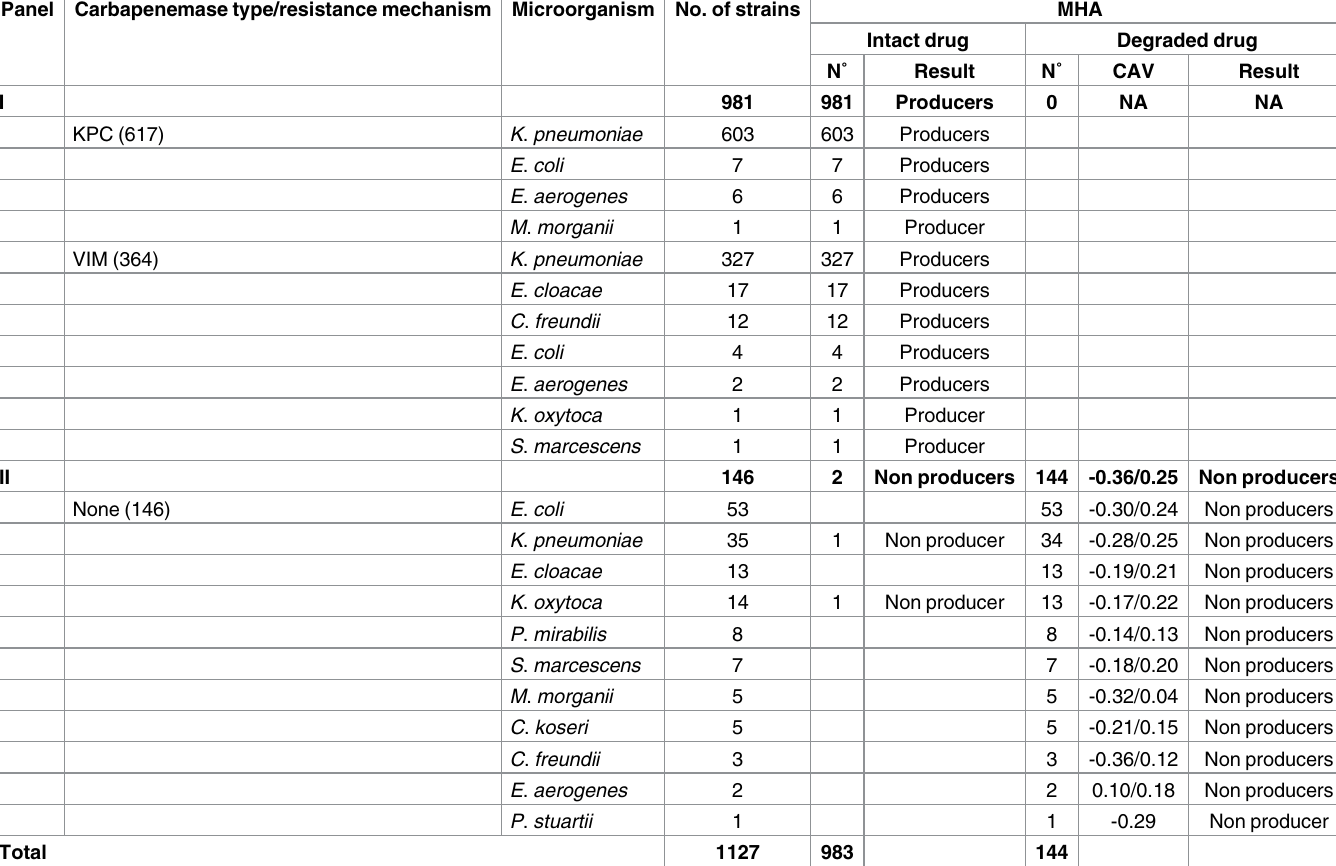
Table 2. Results of Meropenem Hydrolysis Assay(MHA) in case of intact or degraded drug in 1127 Enterobacteriaceae strains included in the pan- els I and II. Panel Carbapenemase type/resistance mechanism Microorganism No. of